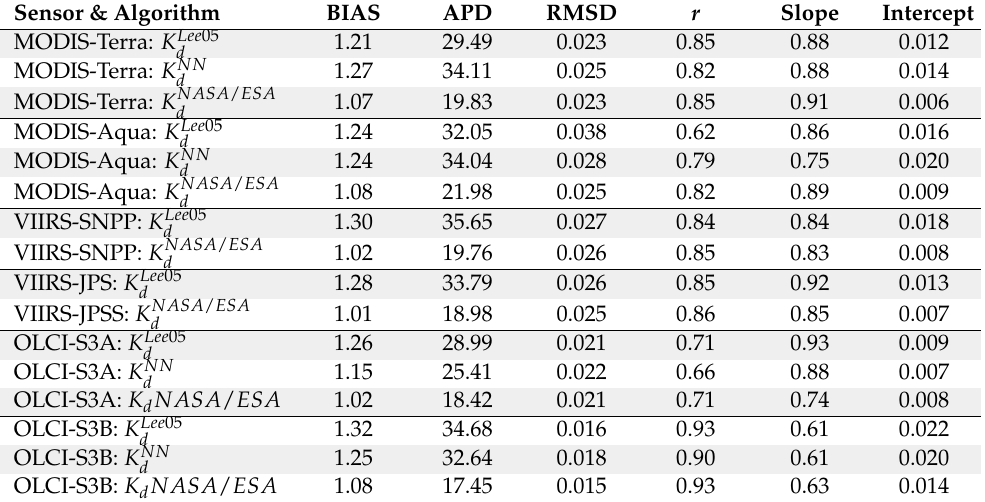
Table A5. Summary statistics at 490 nm when biomes 18 and 19 are removed from the full dataset— 5425 profiles removed, corresponding to the ones located in the Mediterranean and the Black Sea.